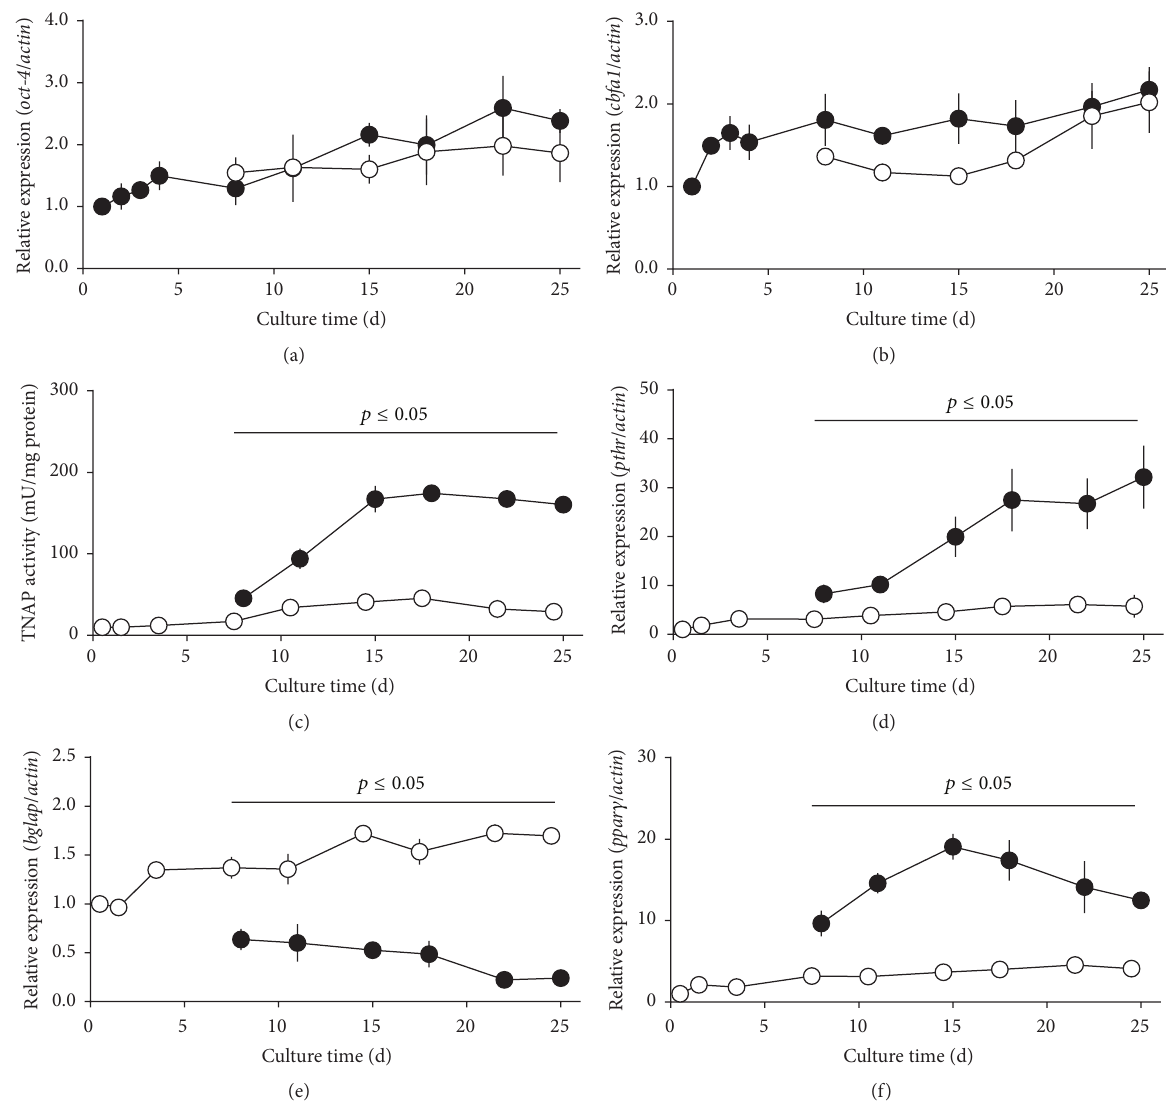
Figure 5: Influence of culture time and dexamethasone on hBMSC differentiation. hBMSC in passage 1 were plated in BM (basic medium) ontoTCPS(=P2).Fromday4afterplating,thecellswereculturedeitherinBM(opencircles)orinOM/D(osteogenicdifferentiationmedium; black circles). At indicated time points (days 1, 2, and 4 in BM, and days 8, 11, 15, 18, 22, and 25 in both BM and OM/D) the cells were analyzed for the expression of octamer binding transcription factor 4 ( oct-4 , (a)), core-binding factor subunit alpha-1 ( cbfa1 , (b)), parathyroid hormone receptor ( pthr , (d)), bone gla protein ( bglap , (e)), and peroxisome proliferator-activated protein 𝛾 ( ppar 𝛾 , (f)). Relative gene expression (gene of interest) was assessed by real time PCR and normalized to the expression of beta-actin as house-keeping gene by comparative quantitation analysis setting day 1 in BM = 1. TNAP activity (c) was determined as described above. Significant differences of OM/D versus BM were analyzed for each time point with 𝑡 -test and were indicated ( 𝑝 ≤ 0.05 ), 𝑛 = 4